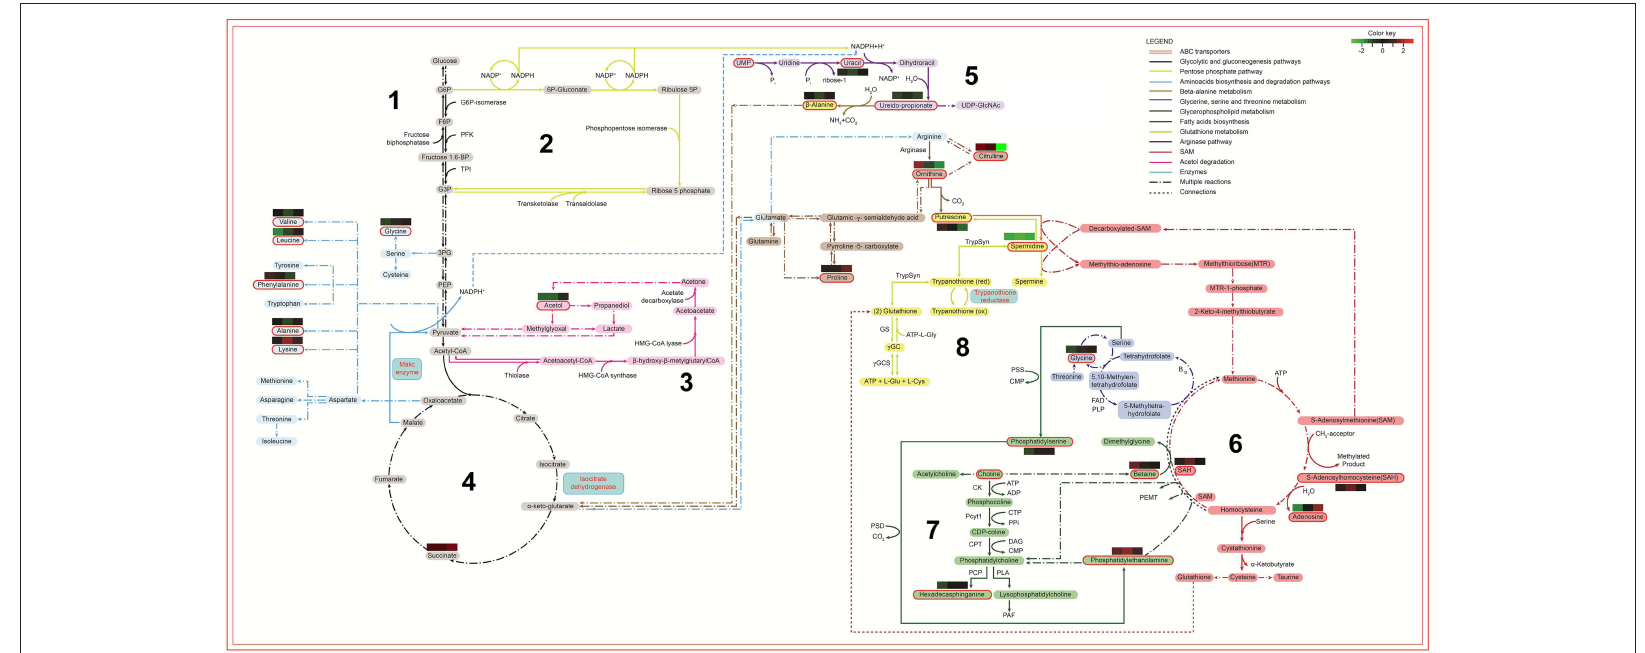
FIGURE 9 | Biochemical map of potential metabolic alterations occurred during axenization of L. amazonensis . Metabolites are represented by colored rectangles. Metabolites identified via metabolomic analysis are highlighted with a red contouring. The colored rectangles localized above/under metabolites represent the relative difference of abundance by comparing R10, R40, and R60 to R0 (left to right, respectively). Arrows represent reactions with enzymes, co-enzymes, metabolites or derivatives, indicated by their respective names or initials. Period-dash-period arrows indicate the occurrence of multiple reactions. Small dashes indicate interconnection of metabolic data between different metabolic pathways. The colors of arrows identify their respective pathways: 1. Black for energetic pathways (glycolytic and gluconeogenesis); 2. Yellow-green for pentose shunt (starting in G6P); 3. Light blue for amino acids biosynthesis; 4. Purple for fatty acids biosynthesis (receiving NADPH from pentose shunt and from malic enzyme reaction); 5. Light brown for β -alanine degradation (starting with ureidopropionate and culminating in α -keto-glutarate); 6. Dark brown for arginase and bright yellow for trypanothione (both pathways are connected in the production of putrescine); 7. Red for SAM or AdoMet pathway (interconnected to the Kennedy pathway, producer of phosphatidiletanolamine, phosphatidilcholine and phosphatidilserine); 8. Dark blue for glycine, serine and threonine biosynthesis. G6P, Glucose 6 phosphate; F6P, Fructose 6 phosphate; Fructose 1,6 bp, Fructose 6 bi-phosphate; PFK, phosphofructokinase; TPI, Triose phosphate isomerase; G3P, Glyceraldehyde 3-phosphate; 3PG, 3-phosphoglycerate; PEP, Phosphoenolpyruvate; UMP, Uridine monophosphate; UDP-GlcNac, Uridine diphosphate N- acetylglucosamine; HMG-CoA-Synthase, Hydroxymethylglutaryl-CoA synthase; NADPH, Nicotinamide adenine dinucleotide phosphate; ACP, Acyl carrier protein; TrypSyn, Trypanothione synthase; TrypRed, Trypanothione reductase; Gly, Glycine; Glu, Glutamine; ATP, Adenosine triphosphate; GS, Glutamine synthetase; SAH, S-adenosylhomocysteine; SAM, S-adennosylmethionine; PSS, phosphatidylserine synthase; PSD, Phosphatidylserine decarboxylase; CMP, Cytidine monophosphate; CK, Choline kinase; Pcyt1, Pyruvate carboxylase t1; CPT, Carnitine palmitoyltransferase; PLA, Phospholipase A; CTP, Phosphocholine cytidylyltransferase; ADP, Adenosine diphosphate; DAG, Diacylglycerol; PAF, Platelet-activating fator; PPi, Cytosolic pyrophosphate; PCP, Pyrrolidone carboxyl